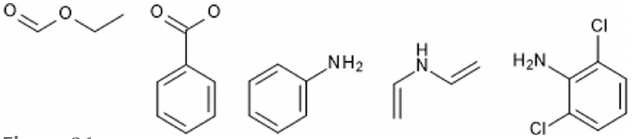
Figure 21 Final set of fragments for